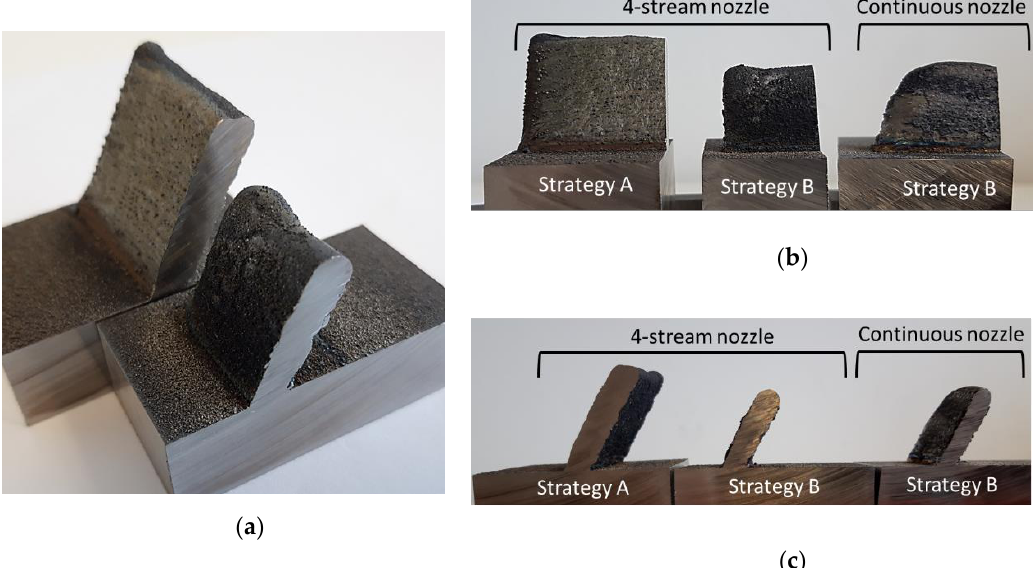
Figure 15. Walls at 30 ◦ : ( a ) comparison of walls fabricated with Strategy A and Strategy B and the four-stream nozzle; ( b ) distortions in the edges of the walls; ( c ) cross-section at di ff erent